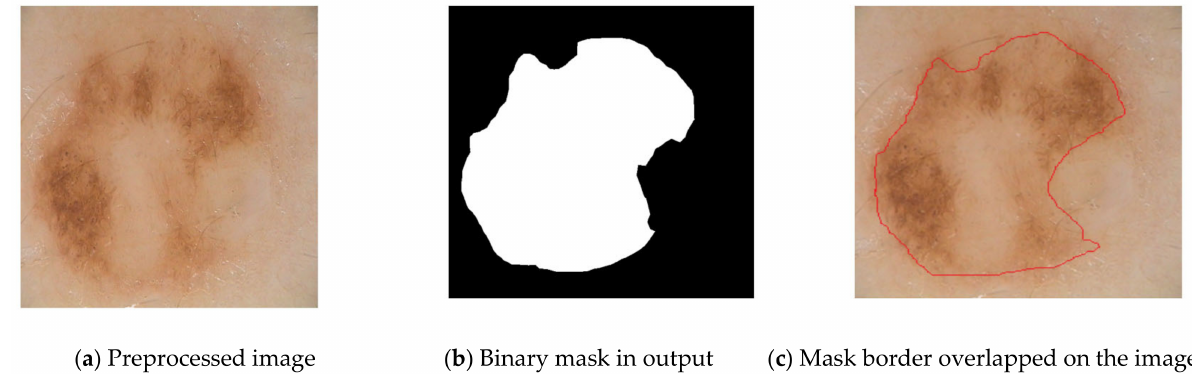
Figure 4. An example for a segmented skin